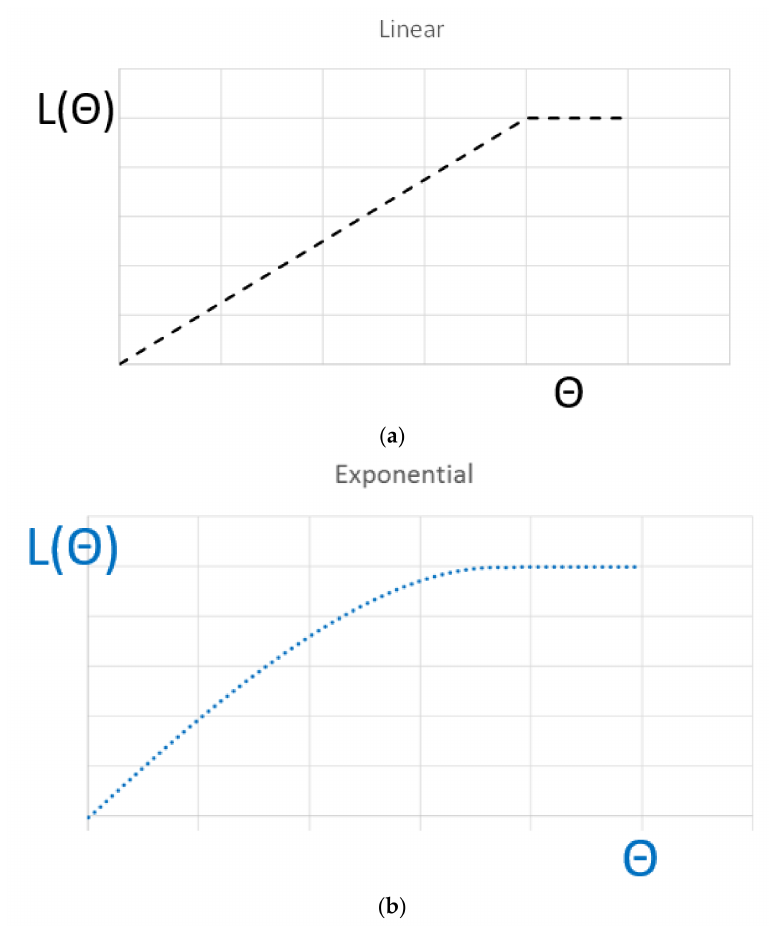
Figure 3. ( a ) Loss model L ( Θ ), linear; ( b ) loss model L ( Θ ),